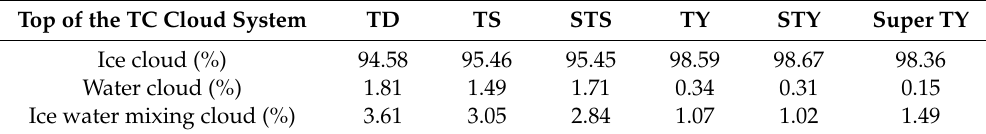
Table 4. Cloud type on the top of TC cloud system by di ff erent TC